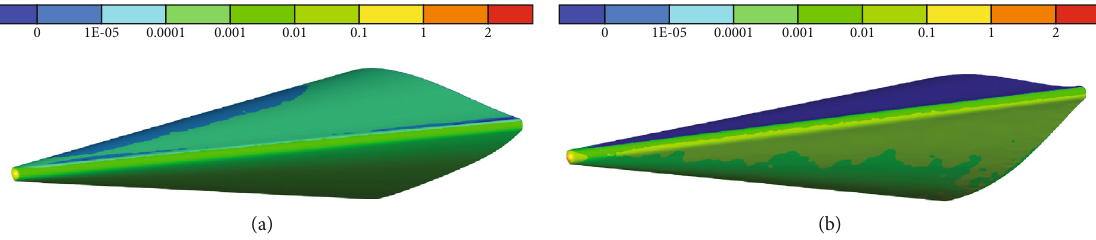
Figure 10: Pressure coe ffi cient distribution on the surface: (a) the baseline and (b) the optimum.